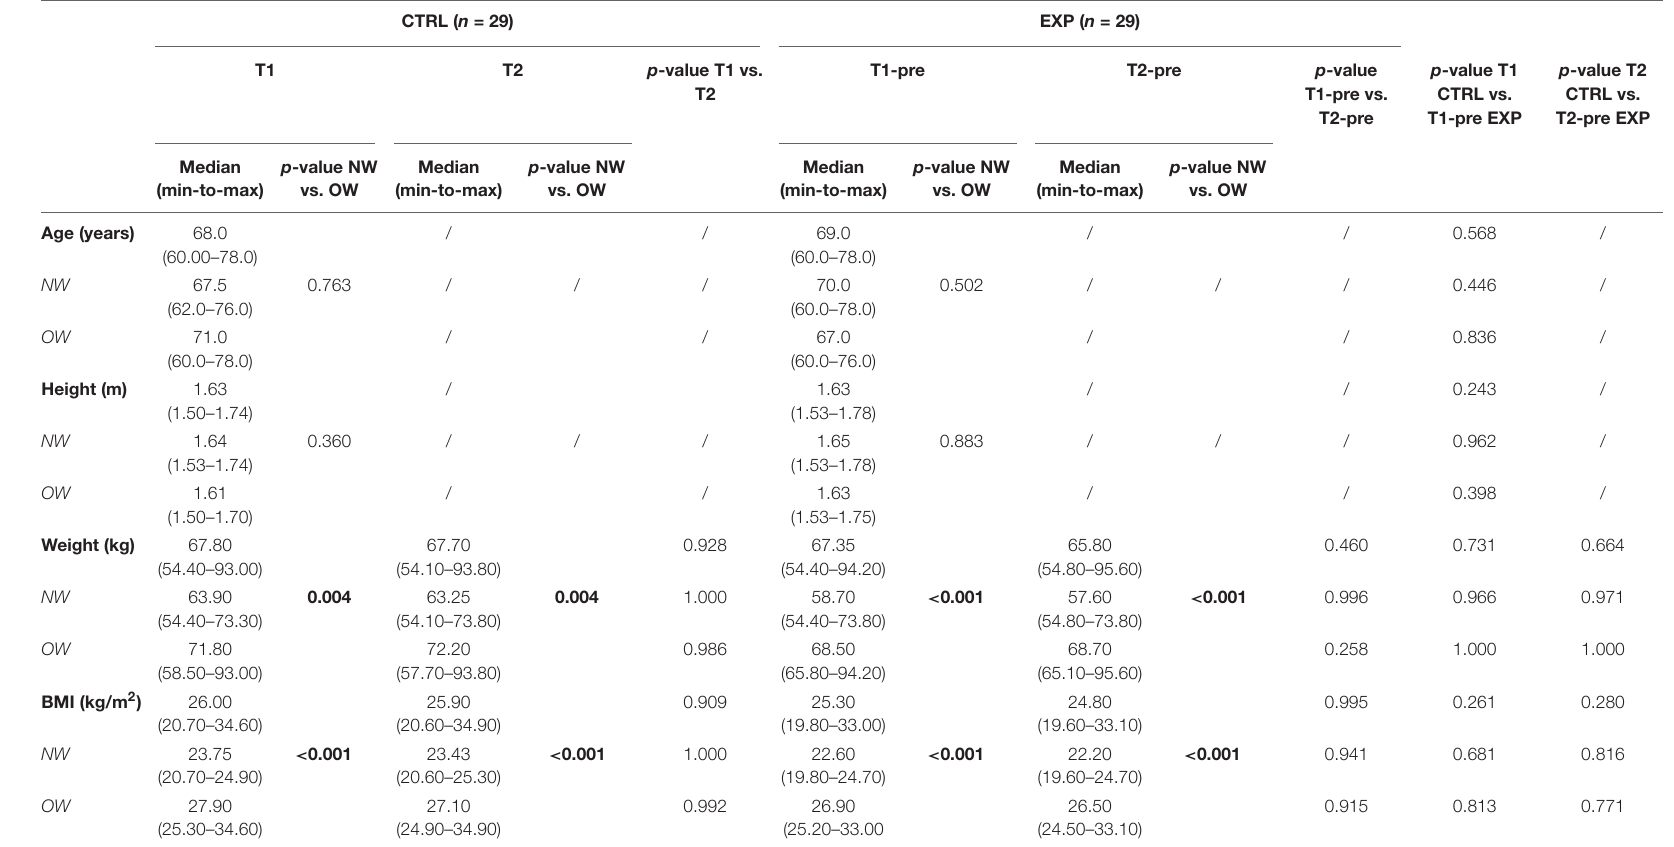
TABLE 1 | Anthropometrical characteristic of the study